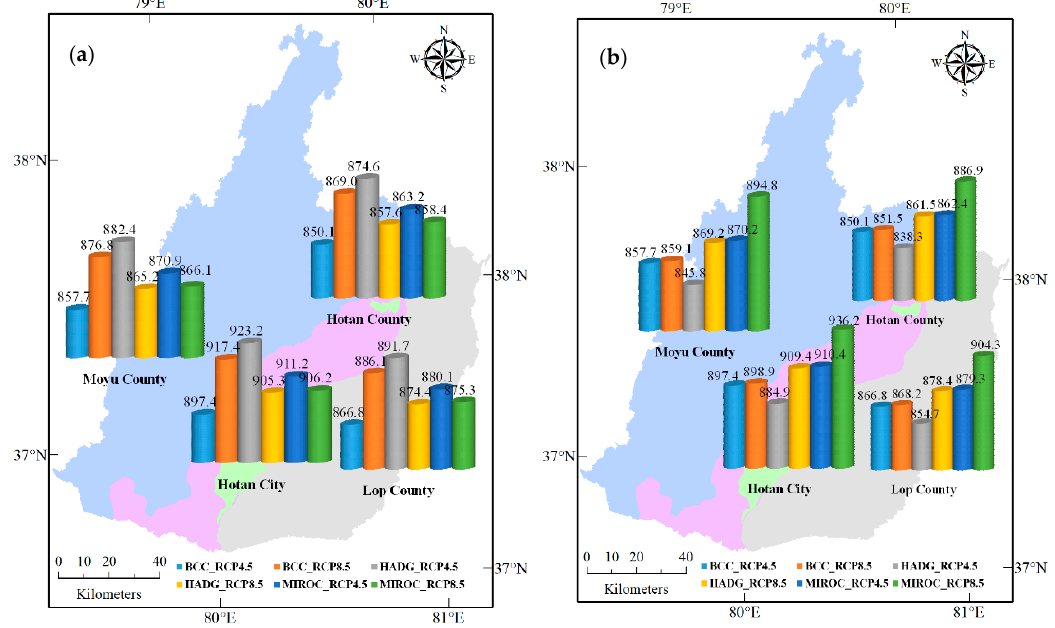
Figure 6. The annual spatial pattern irrigation demand, in the future, ( a ) 2021–2030, ( b ) 2031–2040.